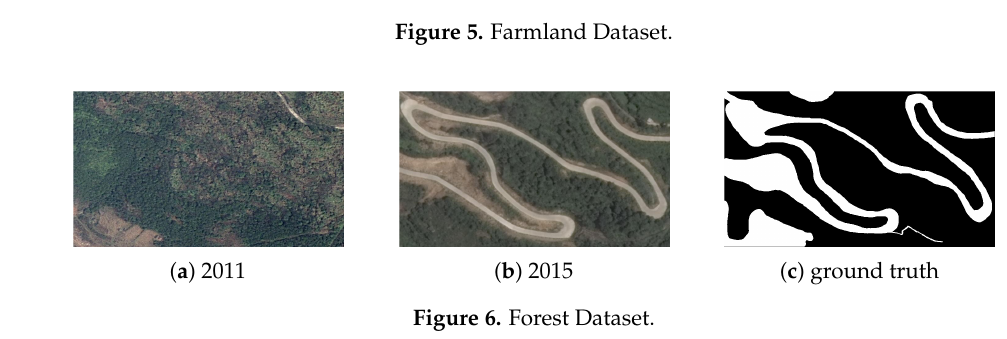
Figure 5. Farmland Dataset.